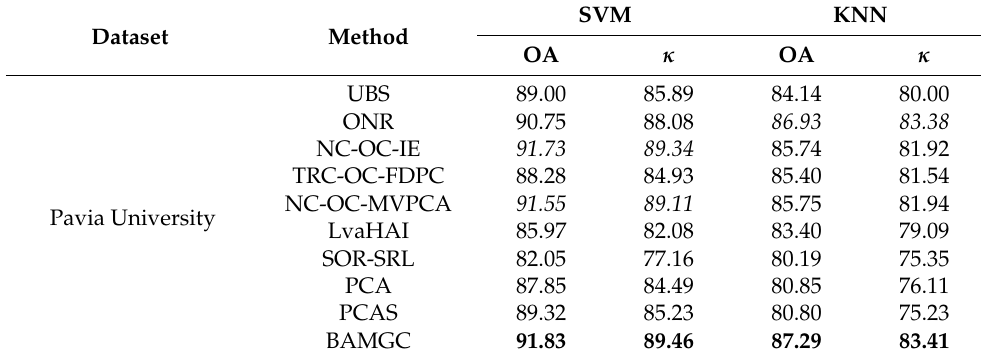
Figure 11. The visualization of classification on the University of Houston dataset. ( a ) Ground truth; ( b ) UBS; ( c ) ONR; ( d ) TRC-OC-FDPC; ( e ) PCA; ( f ) NC-OC-IE; ( g ) NC-OC-MVPCA; ( h ) TRC- OC-FDPC. Table 3. Results of each algorithm in different datasets with 15 bands